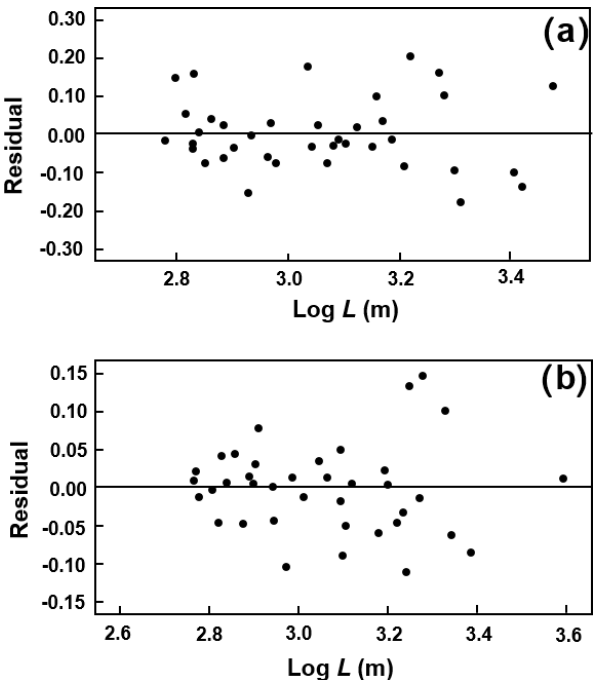
Figure 8. Residual plots for the two multivariate regression models: Fig. 9a is for Eq. (2) and Fig. 9b is for Eq.